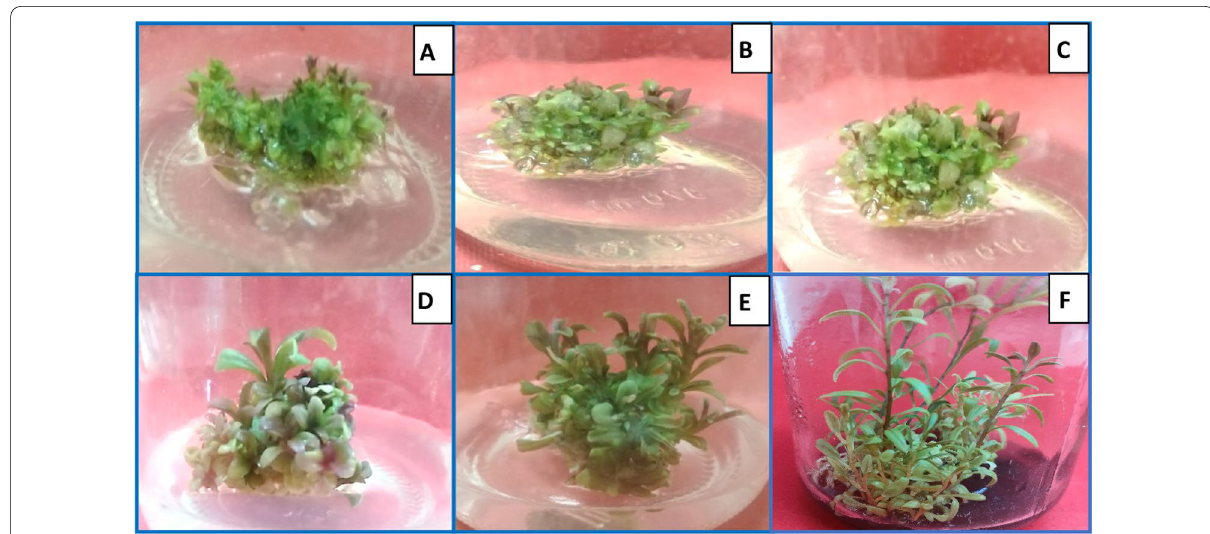
Fig. 5 In vitro regeneration via direct organogenesis from proximal leaf explant of wild L. barbarum. a : Swilling of leaf buds. b : Organogenesis